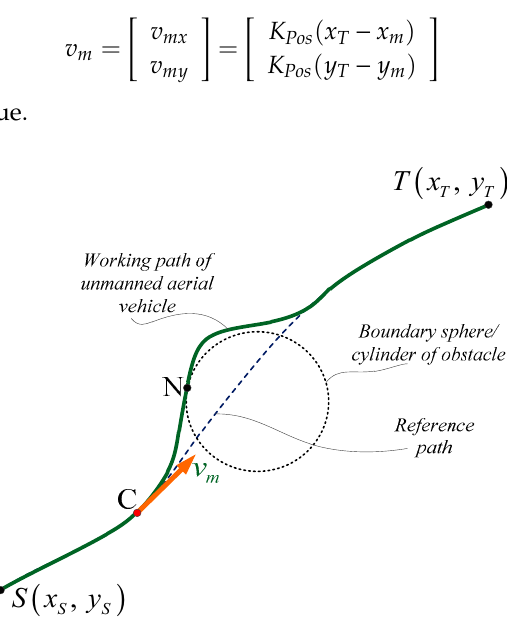
Figure 4. The movement strategy of the vehicle.